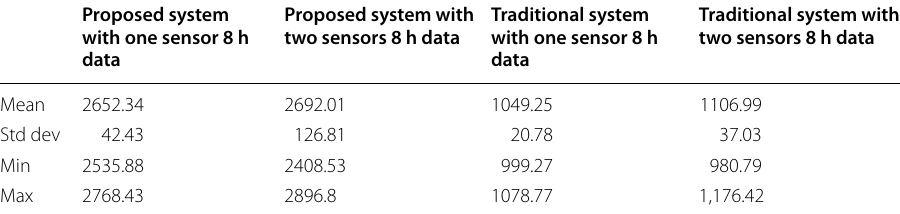
Table 2 Throughput evaluation